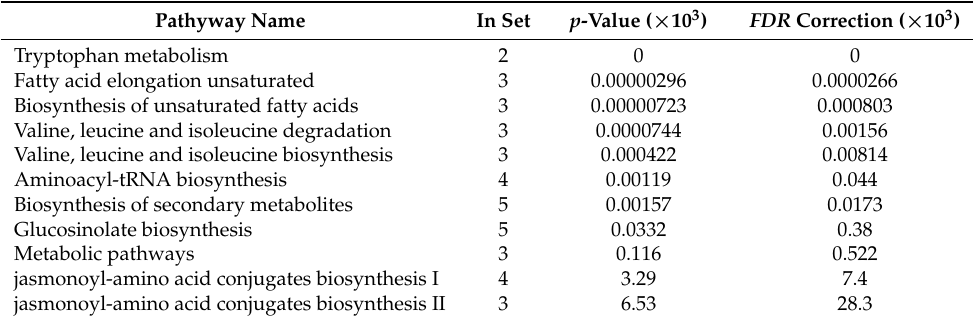
Table 3. The information of the relevant metabolic pathways.